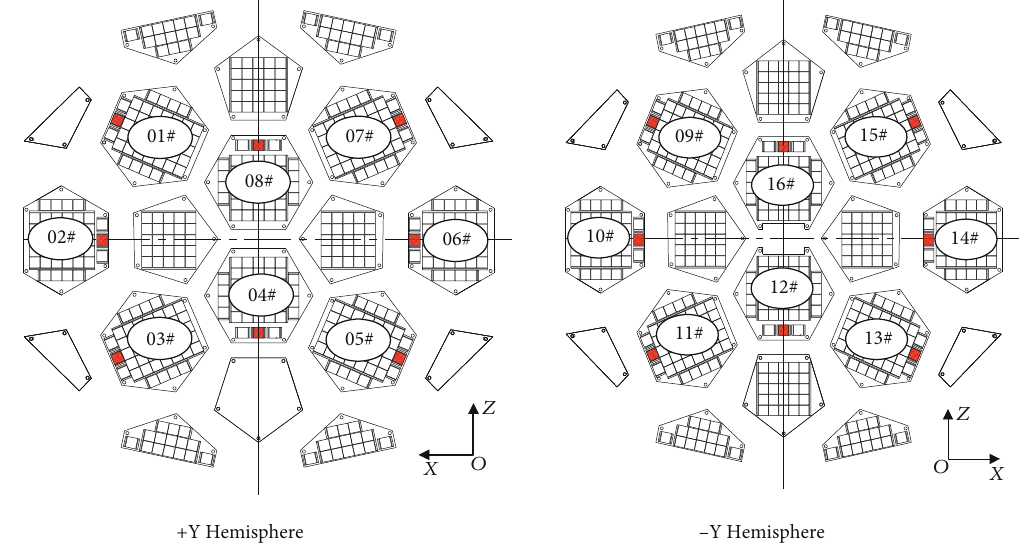
Figure 14: Thermistors on the hemispheres with numbers.